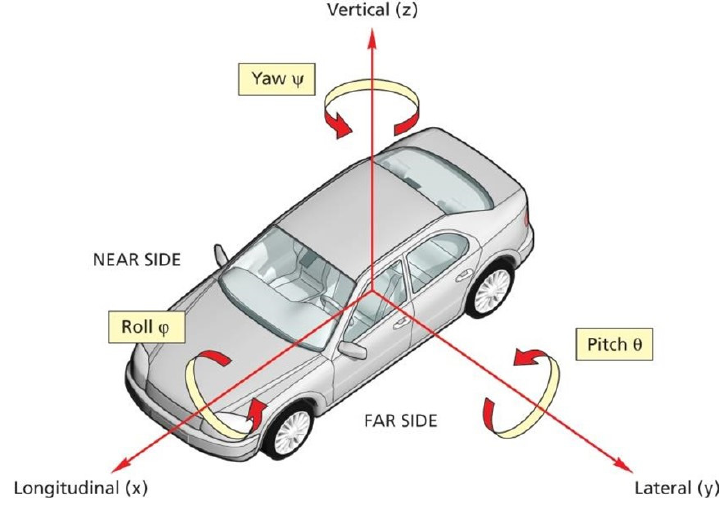
Figure 1. Reference system convention according to Euro NCAP.